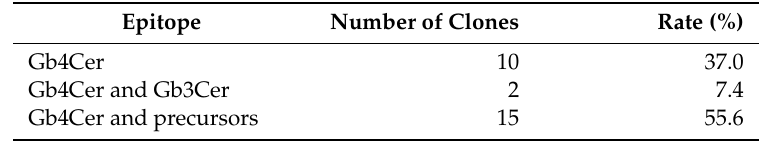
Table 2. Number of hybridoma clones producing antibodies with high reactivity to Gb4Cer and Gb3Cer.